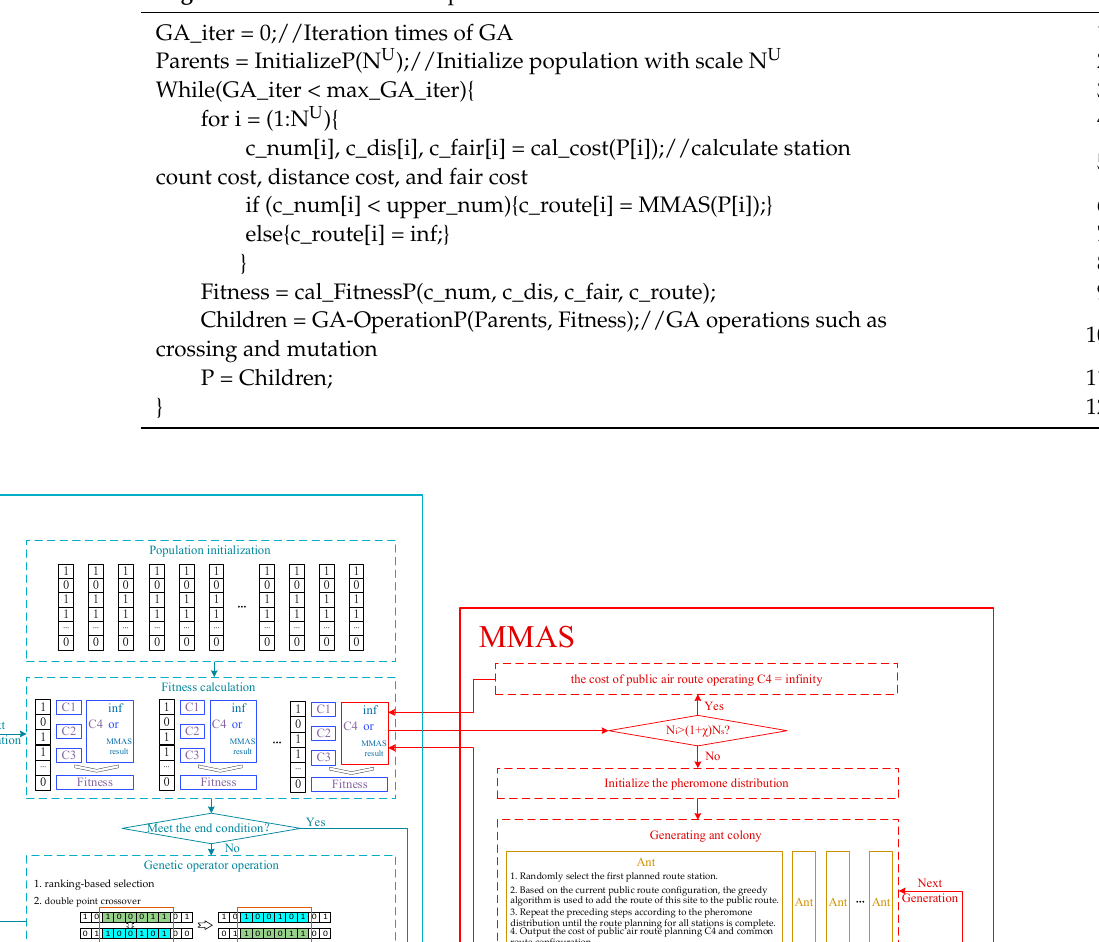
Algorithm 1 The GA-MMAS pseudo-code.